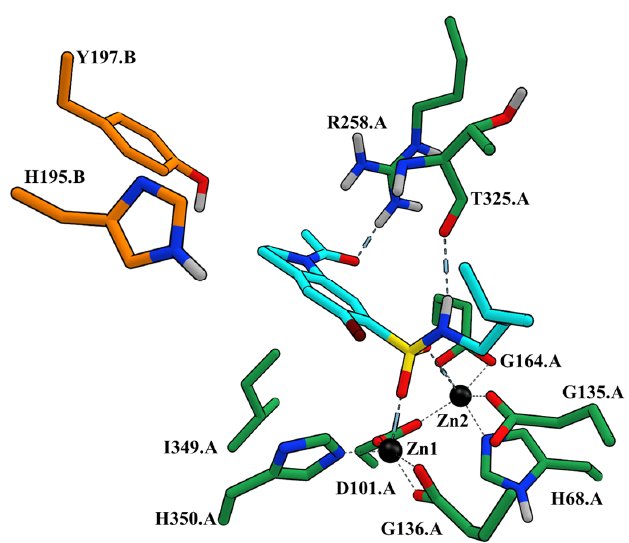
Figure 3. Docked N-isoamyl indoline sulfonamide hit compound 4 (cyan). The majority of the active site residues were contributed to by subunit I of the DapE dimer (green residues), but two residues came from subunit II of the dimer (orange).